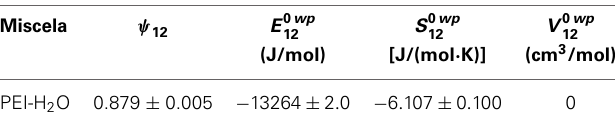
Table 9 | NETGP-NRHB parameters for PEI-water mixture as obtained from fitting of experimental sorption isotherms.